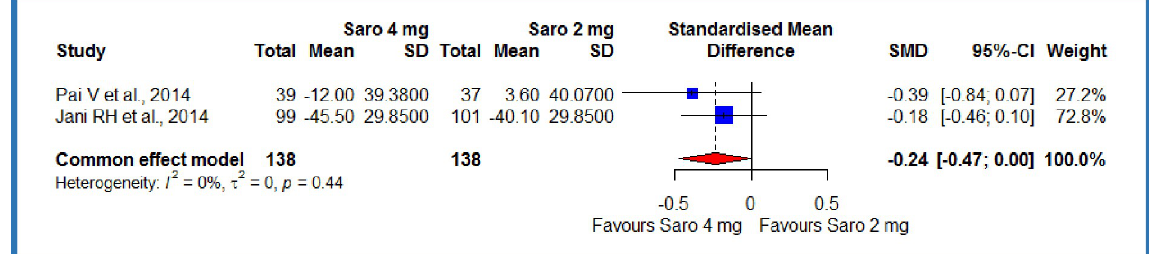
Fig 6. Forest plot of comparison of saroglitazar 4mg versus saroglitazar 2mg on LDL-cholesterol (mg/dL).